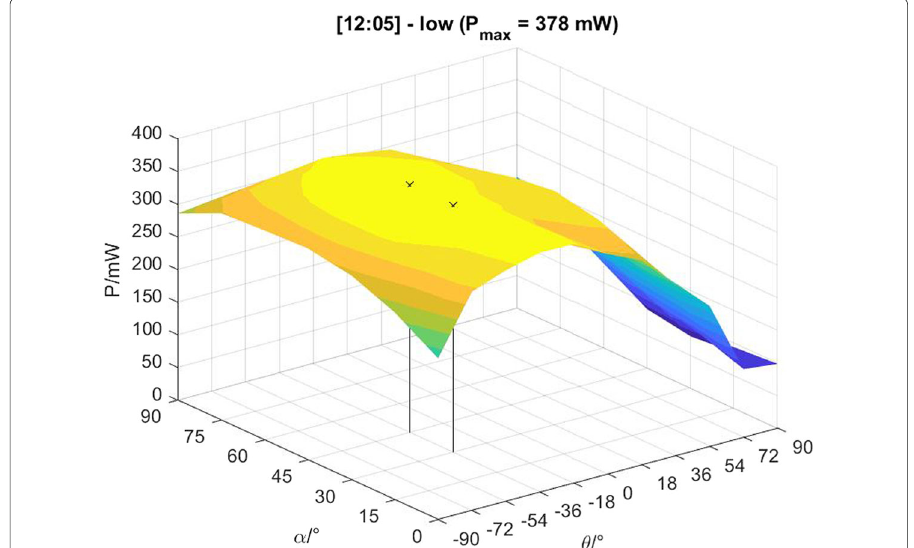
Fig. 9 Power distribution at low